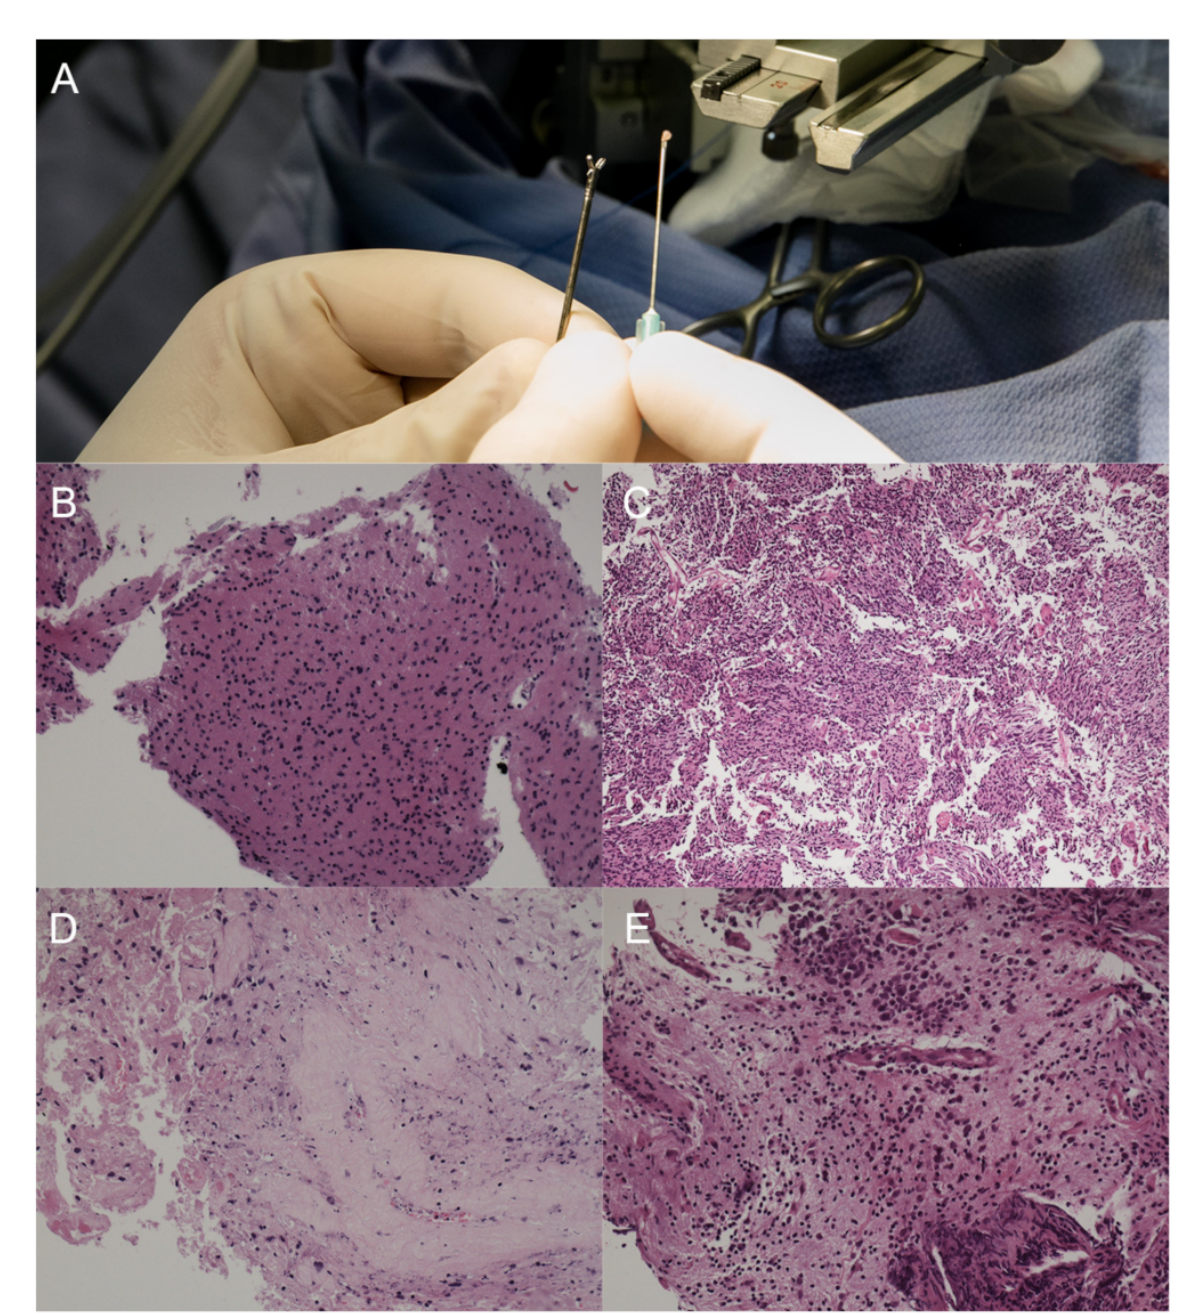
Figure 4. ( A ) The material obtained during a stereotactic biopsy. ( B ) Microscopic image of A2, H&E staining, × 200 mag- nification. ( C ) Microscopic image of A3, H&E staining, × 100 magnification. ( D ) Microscopic image of glioblastoma, H&E staining, × 200 magnification. ( E ) Microscopic image of diffuse large B-cell lymphoma (DLBCL), H&E staining, × 200